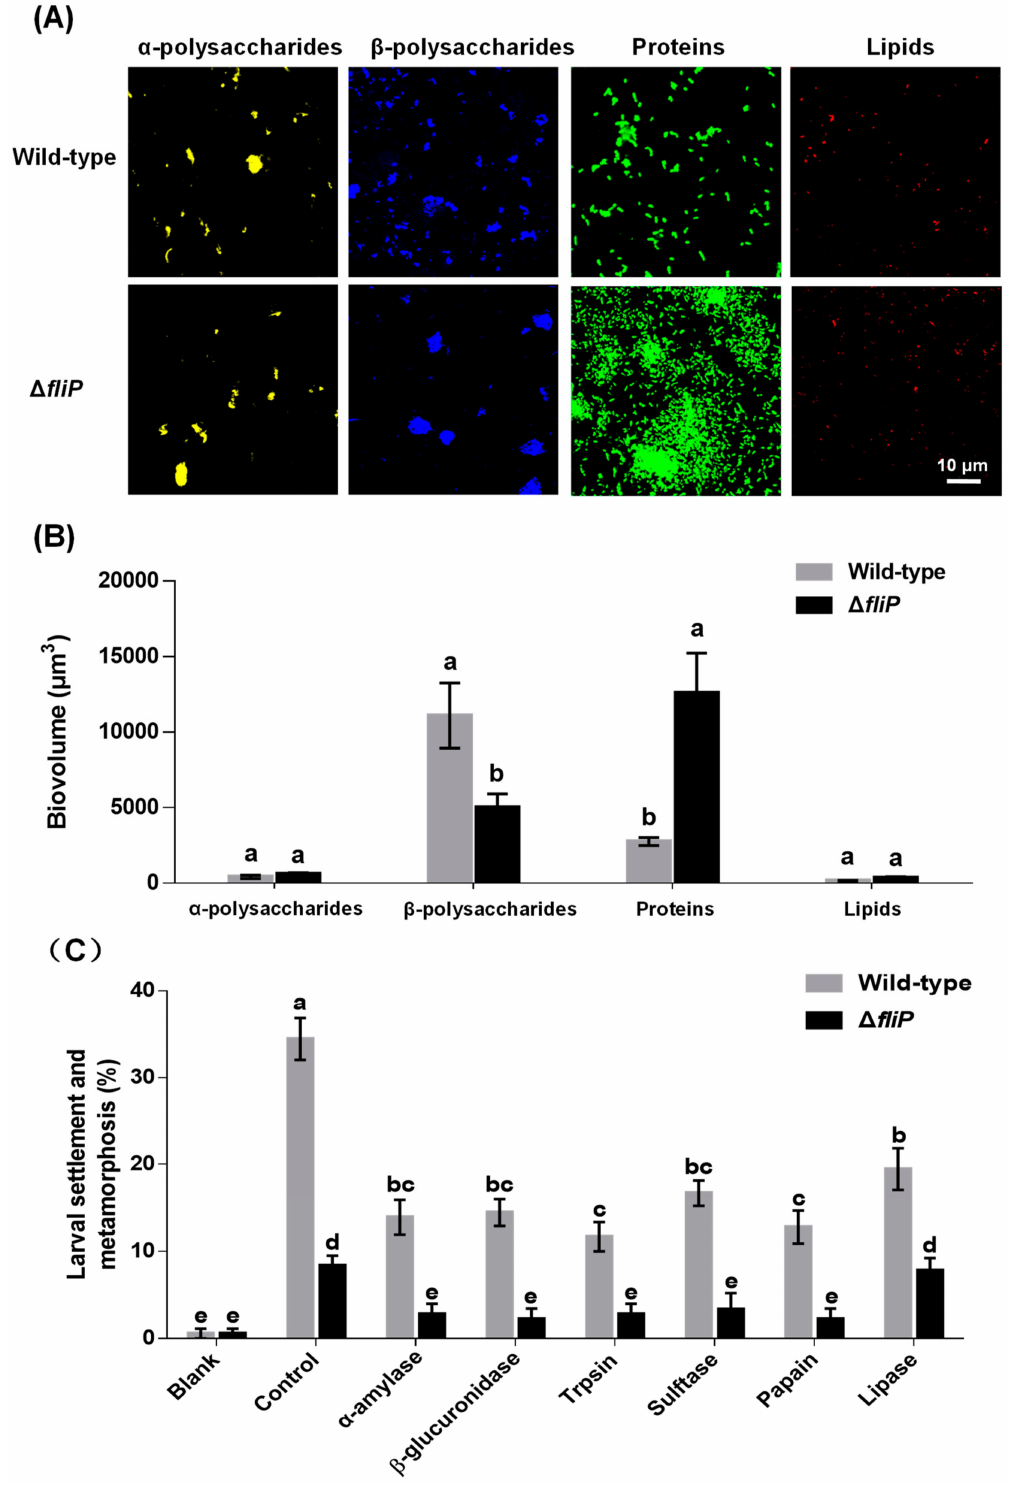
Figure 5. The CLSM analysis of Pseudoalteromonas marina biofilm EPS and mussel settlement and metamorphosis after enzyme treatments. ( A ) Distribution of polysaccharides, proteins and lipids in biofilms of wild-type and ∆ fliP strains; ( B ) Biovolume analysis of extracellular polysaccharides, proteins and lipids content in biofilms; ( C ) Mussel settlement and metamorphosis on biofilms treated by di ff erent proteases, lipases and